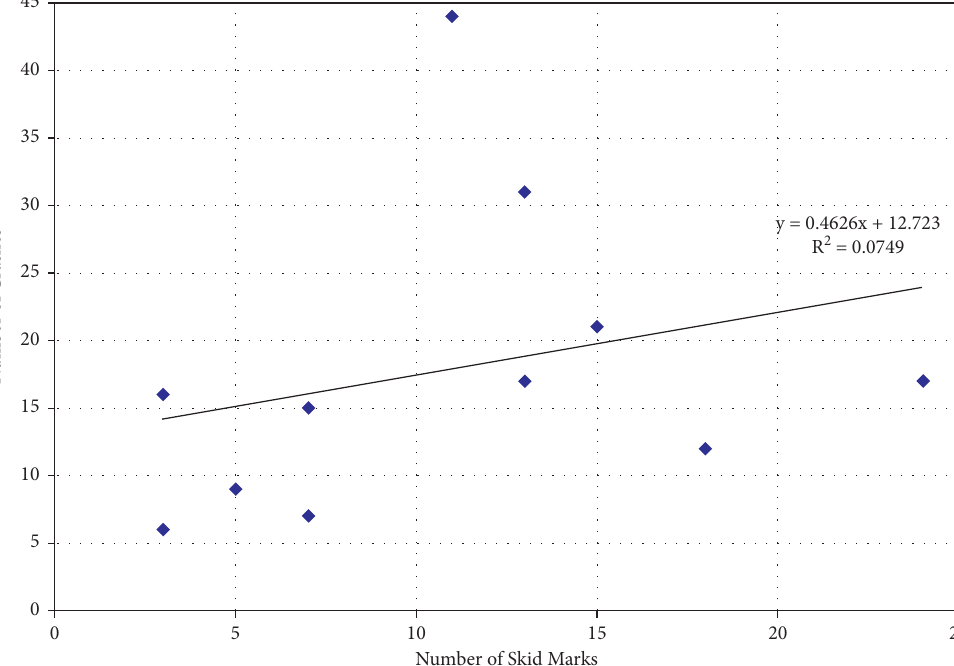
Figure 9: Crash vs. skid correlation by 1-mile segments on Interstate 80